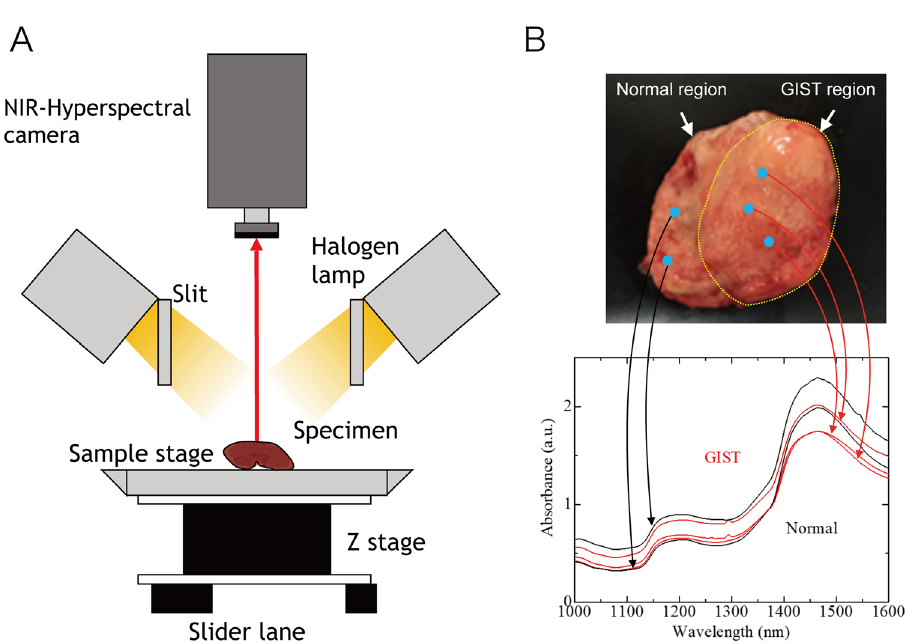
Figure 5. NIR-HSI system and absorbance spectra. ( A ) Setup of NIR-HSI system. ( B ) NIR absorbance spectra of HSI pixels of the GIST (Red) and normal (Black) regions. NIR near-infrared, HSI hyperspectral imaging, GIST gastrointestinal